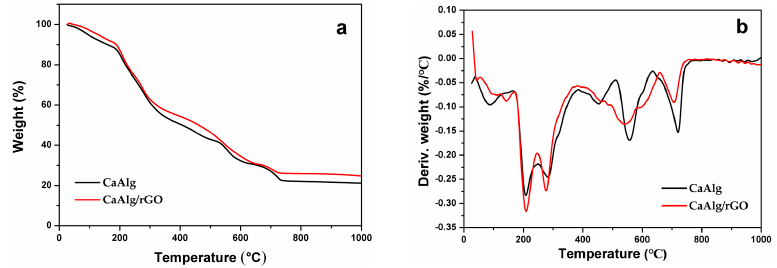
Figure 5. ( a ) TGA and ( b ) DTG of CaAlg and CaAlg/rGO materials under air atmosphere.